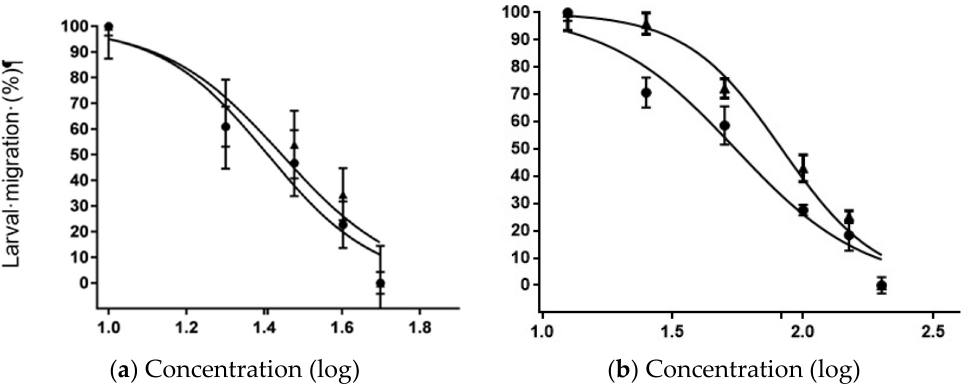
Figure 3. Concentration-dependent ((μg/mL(log)) effect curves for the larval migration test (%) using nematodes of sheep, with the interaction of ( a ) ivermectin alone (triangle) or in combination with the IC 50 of OFIEOH (circle); and ( b ) OFIEOH alone (triangle) or in combination with the IC 50 of ivermectin (circle), obtained from the peels of Opuntia ficus-indica. IC 50 = Inhibitory concentration of 50% of larvae.